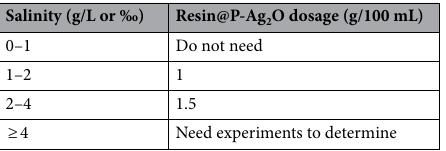
Salinity (g/L or ‰)